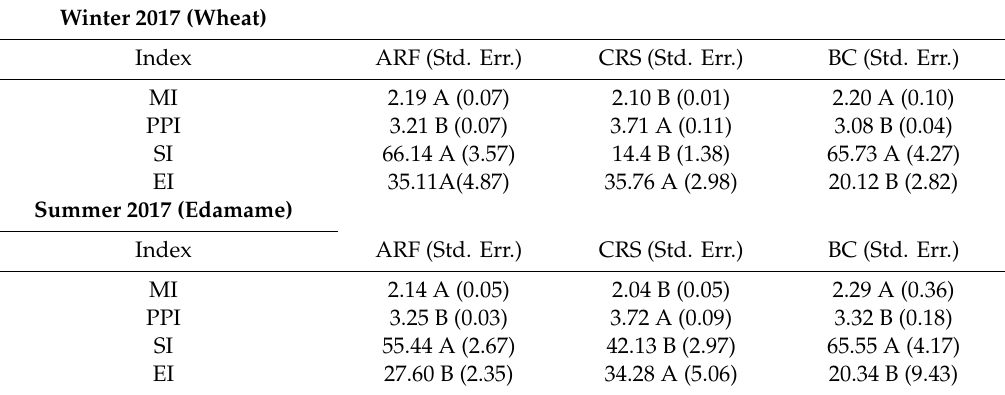
Table 2. Nematode index values of rotation managements, annual ryegrass / fallow (ARF), and cereal rye / edamame soybean (CRS), and bare control (BC) in the winter (above) and summer